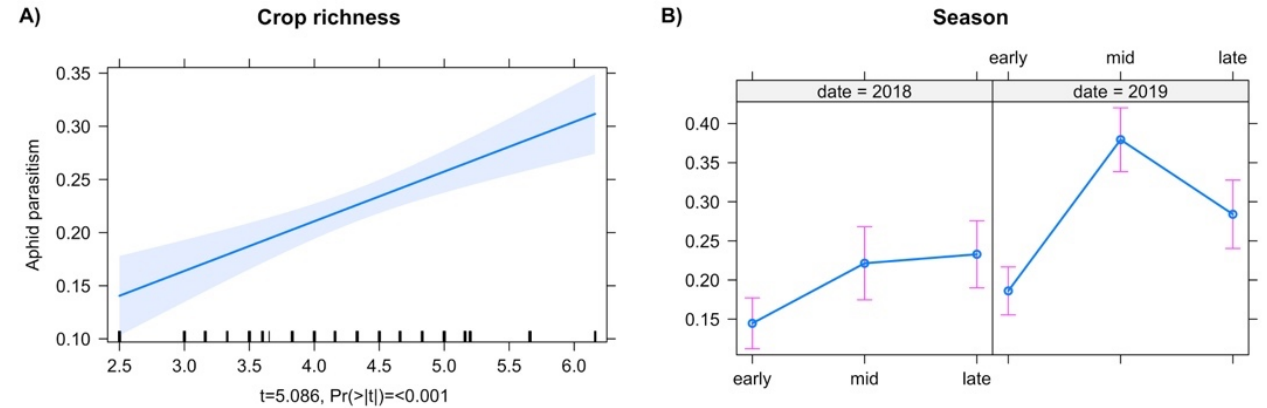
Figure 5. Predictor effect plots for individual explanatory variables. ( A ) Crop richness, ( B ) season and year on rates of parasitism.